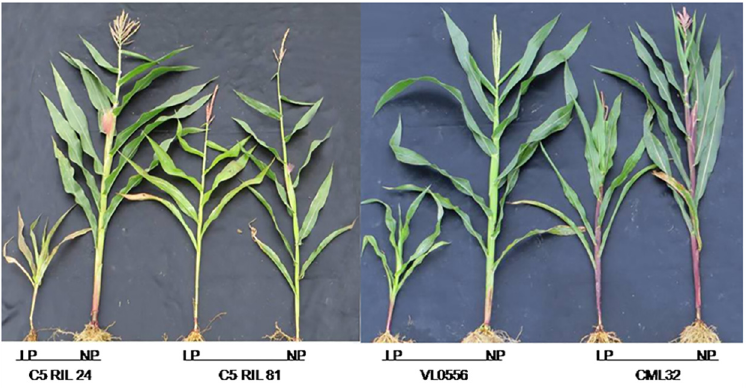
Fig 2. Responses of LP tolerant and susceptible accessions to LP stress. Photos were taken at 57 DAP in 2012.